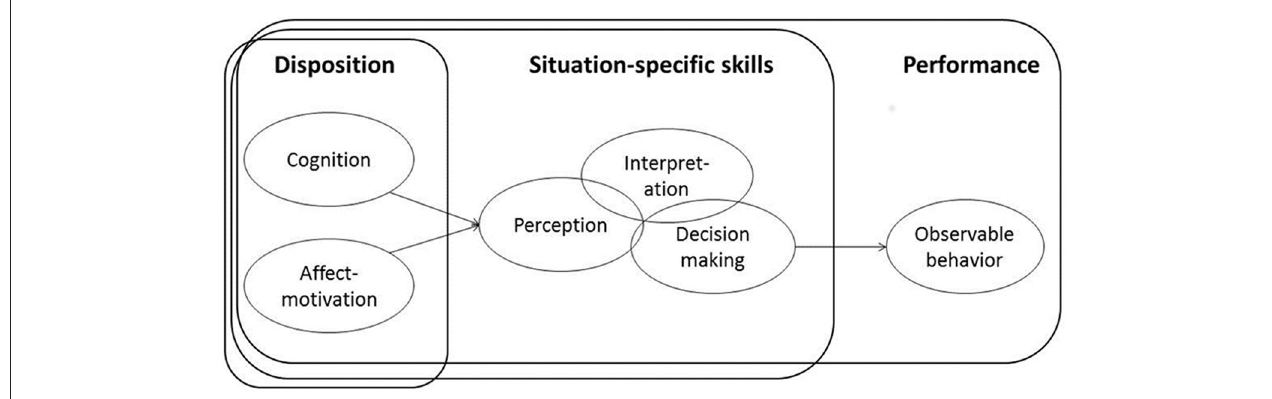
FIGURE 1 | Modeling competence as a continuum (Blömeke et al.,